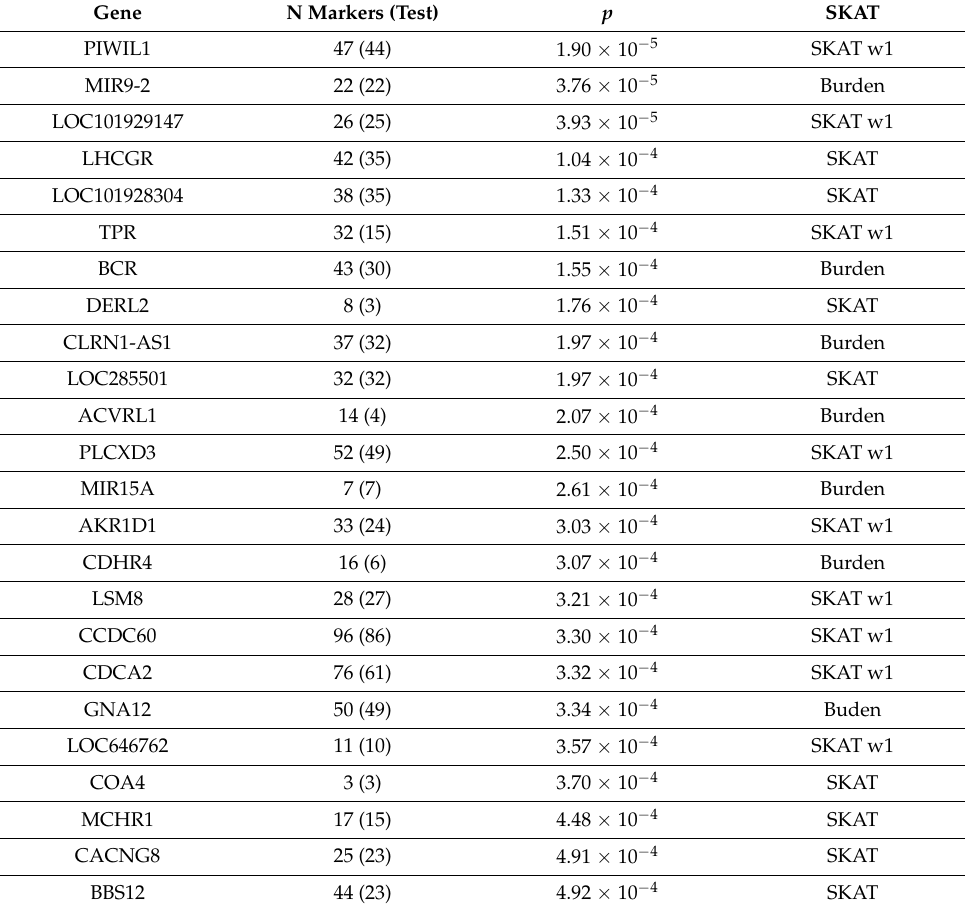
SKAT, SKAT with “beta” weights; SKAT w1, SKAT with the same weights for common and rare variants; BURDEN, Burden